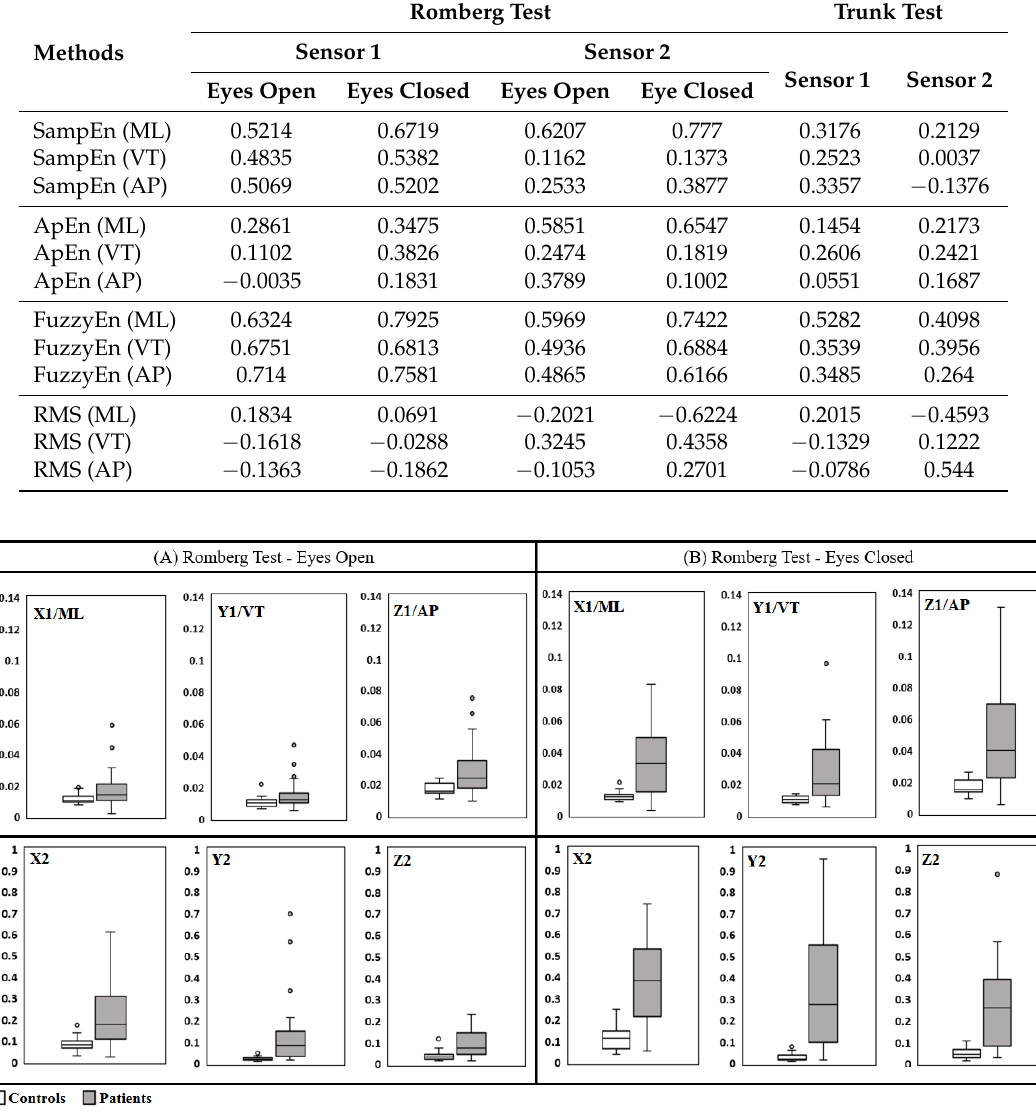
Figure 3. Box-plots of velocity based Fuzzy entropy values in the Romberg test for Sensor 1 (top)